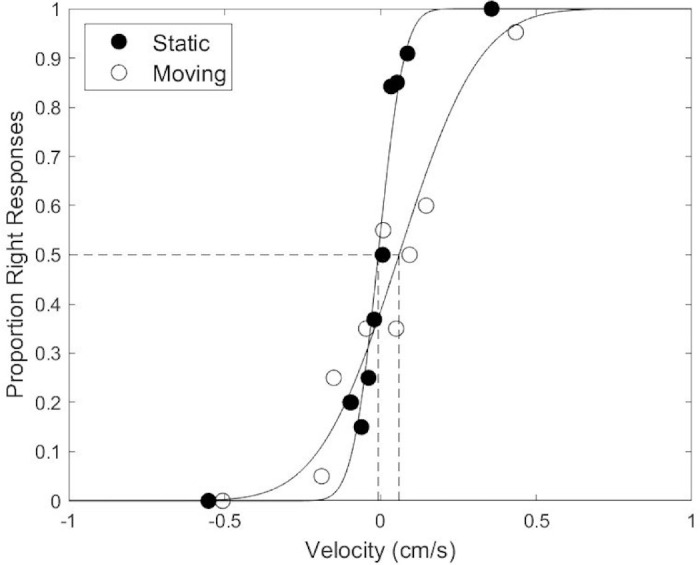
Example psychometric functions from one participant for the static and the moving conditions. Psychometric functions were fitted to the binary response data, while estimated proportion of rightward responses, aggregated over similar velocities, are also shown for illustrative purposes only (filled markers: static condition; unfilled markers: moving condition). Vertical dotted lines indicate the point of subjective equality (PSE) from the psychometric functions fitted to each condition.